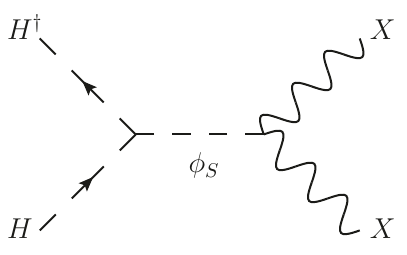
Figure 3 . Feynman diagram to generate the VDM X via the SM Higgs doublet H